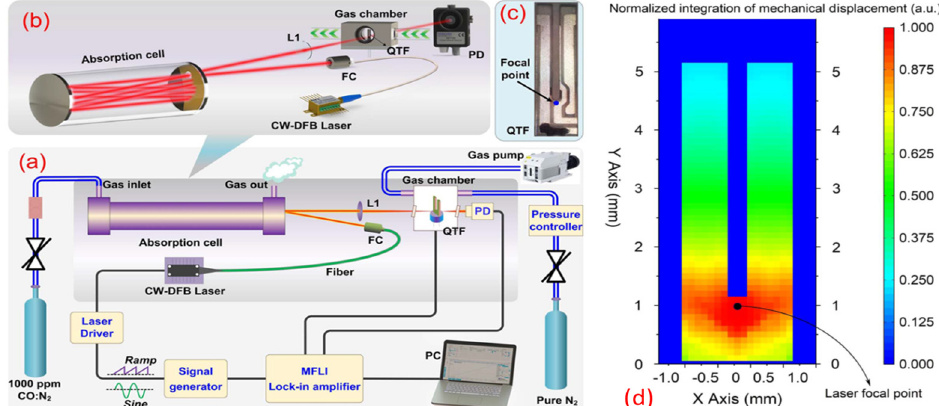
Figure 3. ( a ) Experimental setup of the LITES sensor system. ( b ) The specific optical path structure. ( c ) The image of a QTF. ( d ) Stimulated normalized integration for thermoelastic induced mechanical displacement of the QTF’s surface. L1: lens 1; FC: fiber collimator; QTF: quartz tuning fork; PD: photoelectric detector; CW-DFB Laser: continuous wave distributed feedback laser; PC: